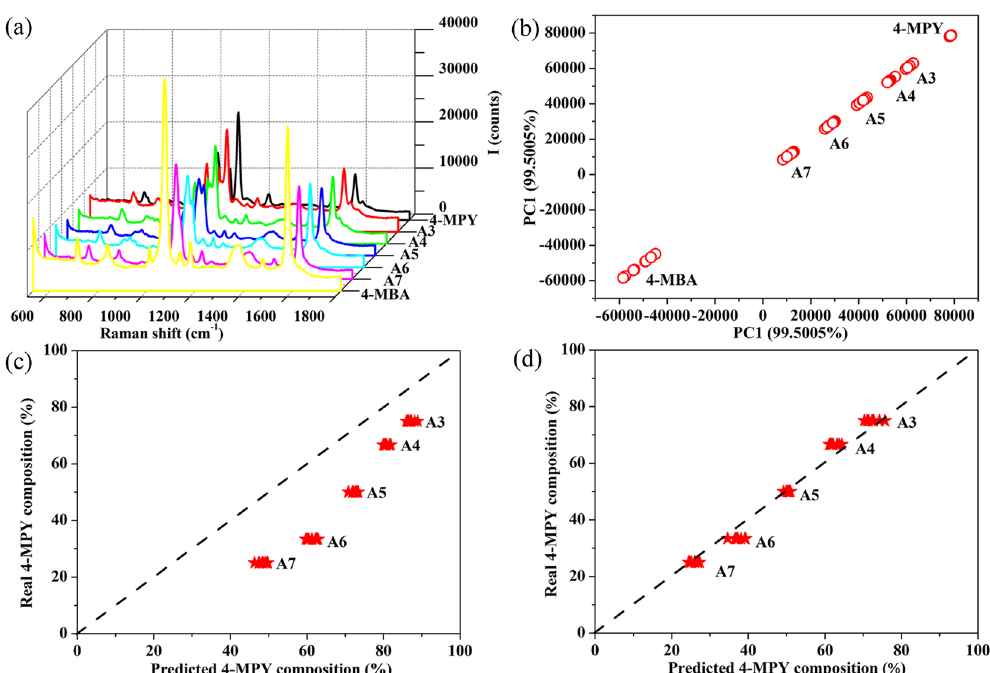
Figure 3. ( a ) SERS spectra of 4-MBA, 4-MPY, and their binary mixture sample A3 to A7. ( b ) Plot of PCA scores for 4-MBA, 4-MPY, and their binary mixture sample A3 to A7. ( c ) Plot of real composition in solution versus composition predicted by PCA. ( d ) Plot of real composition in solution versus composition of corrected PCA